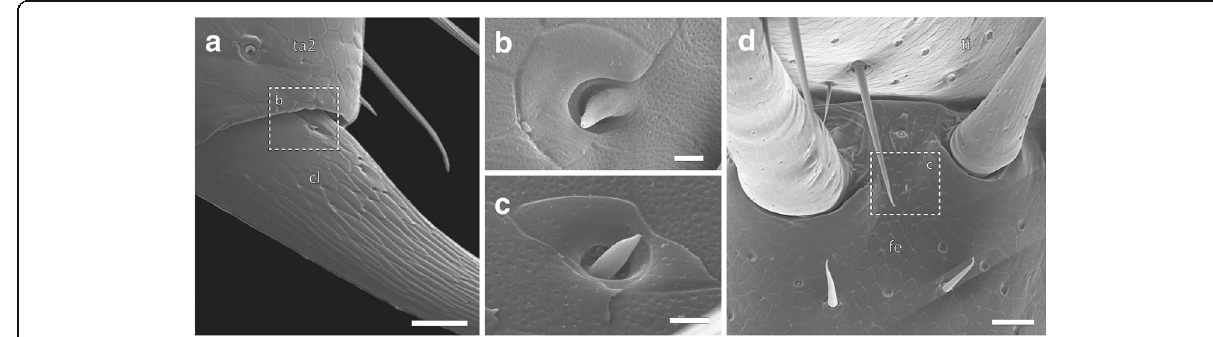
Fig. 7 Sensory cones on the ultimate leg. a Sensory cone on the ventromedial side of the claw. Note that the claw also features a variety of small pores. Scale bar 25 μ m. b Detail of proximal portion of the claw as indicated in a showing the sensory cone with a terminal pore (arrowhead) located in a small depression close to a crescent-shaped cuticular field. Scale bar 2 μ m. c Sensory cone on distal femur. Scale bar 2 μ m. d Ventral femoro-tibial articulation showing the location of a sensory cone on the telopodite. Scale bar 25 μ m. Abbreviations: cl claw, fe femur, ta tarsus, ti